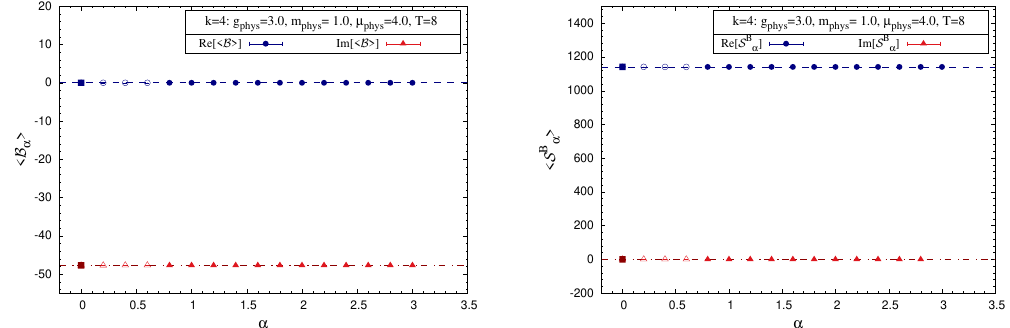
Figure 5 . Expectation values of auxiliary field B α (left) and the bosonic action S B various α values on a lattice with T = 8 . The simulations are for the model with even-degree real polynomial potential Ξ 0 (4) given in eq. (4.7). The parameters used are g phys = 3 , m phys = 1 , and µ phys = 4